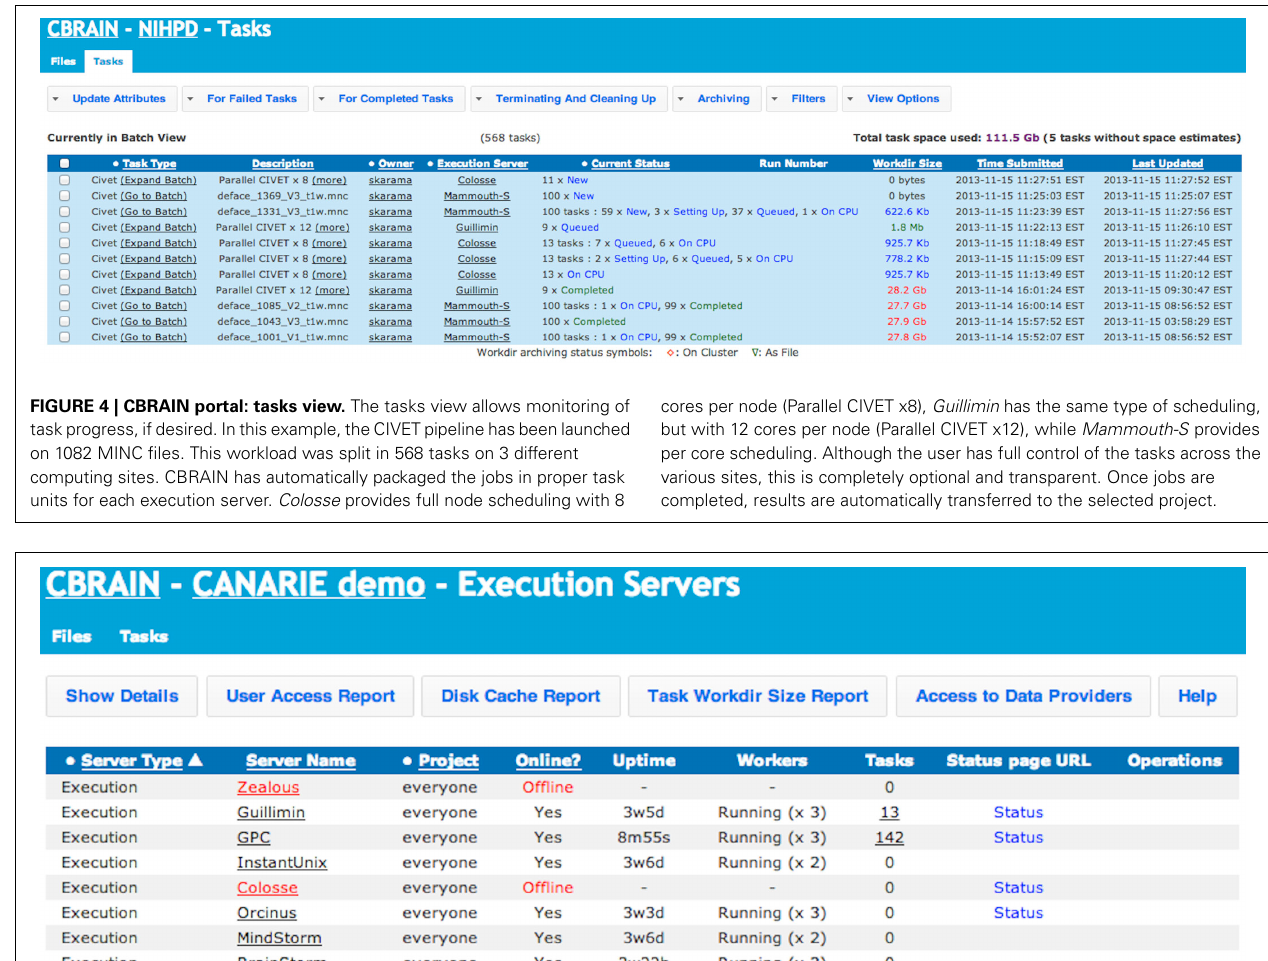
and data provider utilization, and archived work directories. Administrative users can control group access and put the resource online or offline for CBRAIN